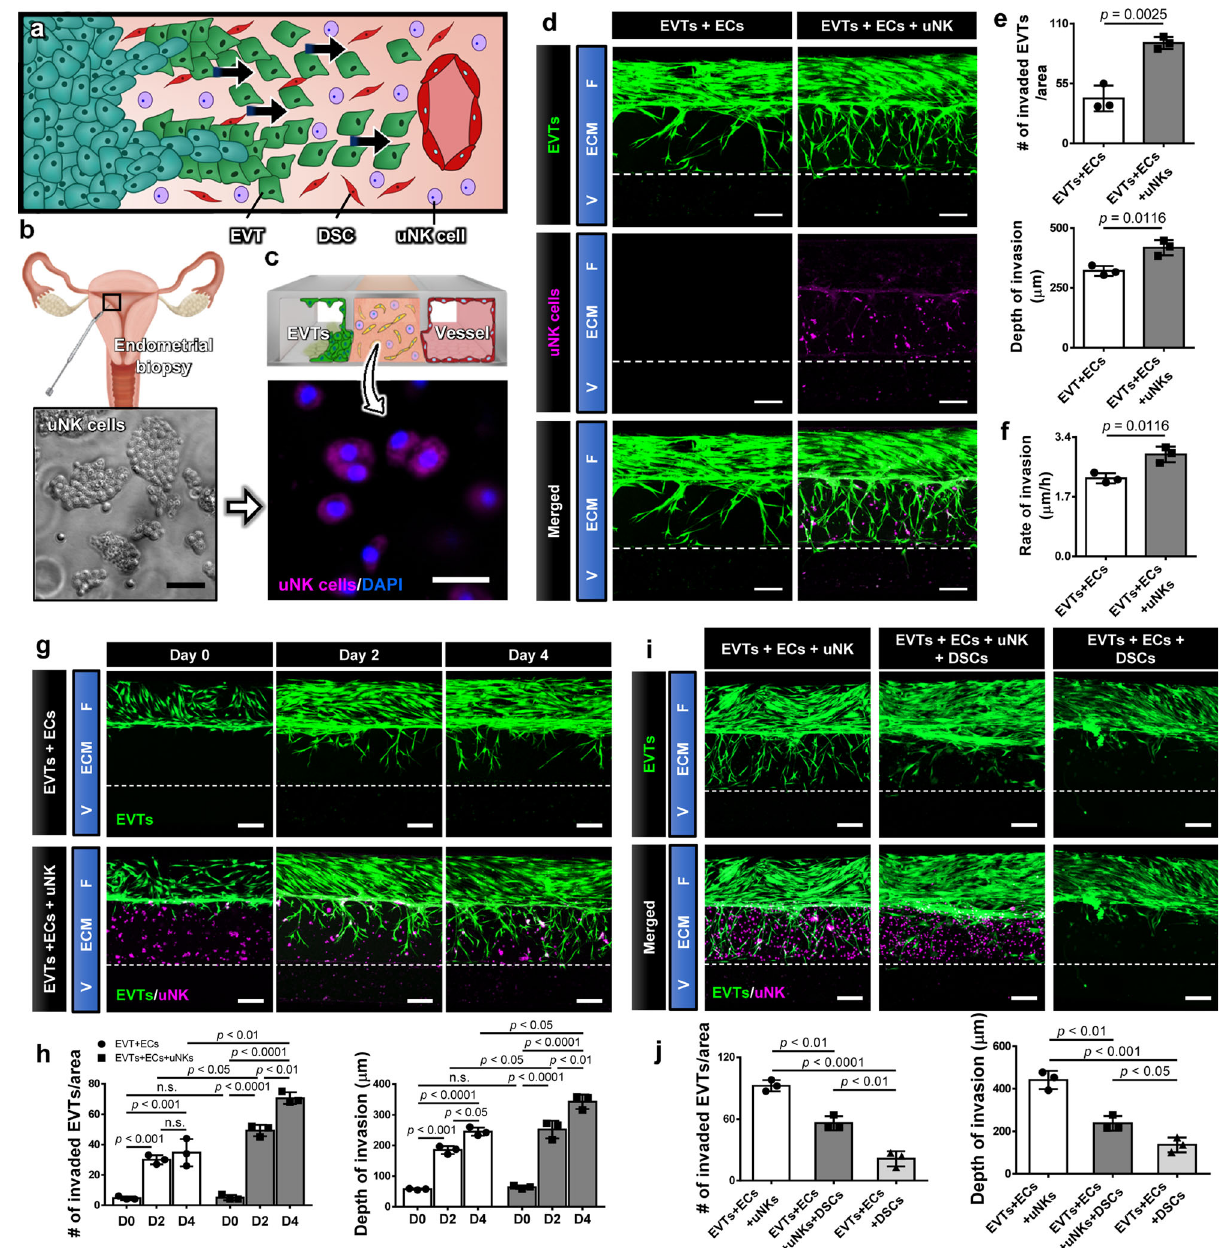
Fig. 7 Immune regulation at EVT invasion by uNK cells. a Uterine NK cells are the most abundant maternal immune cells encountered by invading trophoblasts, and have been suggested to in fl uence EVT invasion. b Isolation of primary human uNK cells from implantation window biopsies taken from non-pregnant endometrium. The representative images are from two independent experiments. Scale bar, 50 μ m. c Encapsulation of uNK cells (magenta) in the hydrogel scaffold of the implantation-on-a-chip device. Blue shows nucelar staining. The representative images are from three independant experiments. Scale bar, 20 μ m. d Promotion of EVT invasion due to uNK cells. Images were captured at Day 6. EVTs and uNK cells were pre-labeled with CellTracker Green and CellTracker Red, respectively. The representative images are from three independent experiments. Scale bars, 200 μ m. e , f Quanti fi cation of the extent and rate of invasion. Two-sided t -test ( n = 3 independent chips per group). g Time-lapse imaging of EVT (green) migration in the presence (bottom images) or absence (top images) of uNK cells (magenta). The representative images are from three independent experiments. Scale bars, 200 μ m. h Quanti fi cation of EVT invasion over 4 days. Two-way ANOVA with Sidak ’ s multiple comparison test ( n = 3 independent devices per group). i , j Analysis of altered EVT invasion due to the addition of DSCs. The representative images are from three independent experiments. Scale bars, 200 μ m. One-way ANOVA with Tukey ’ s multiple comparison test ( n = 3 independent devices per group). Dashed lines in d , g , and i indicate the boundary between the ECM hydrogel compartment and the vascular chamber. Data are presented as mean ± SD. p values are shown on the graphs. uNK cells: Uterine natural killer cells. Source data are provided as a Source Data fi le.